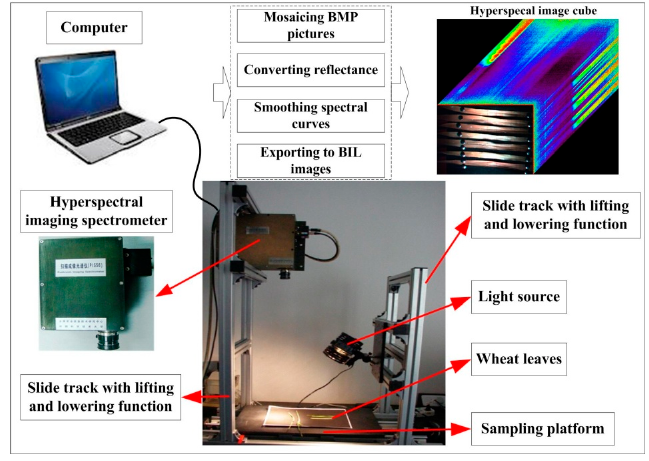
Figure 2. The devices used to measure the hyperspectral reflectance of wheat leaves.